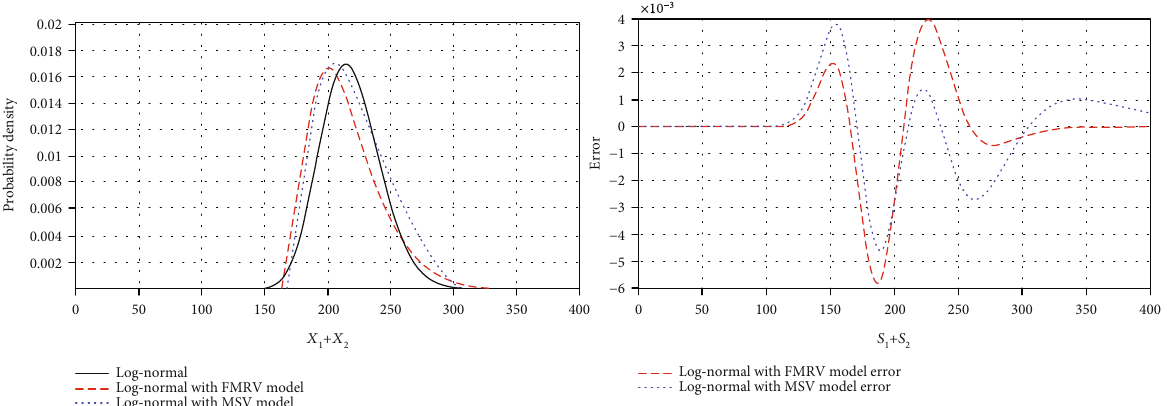
Figure 1: Sum of probability density function and error.